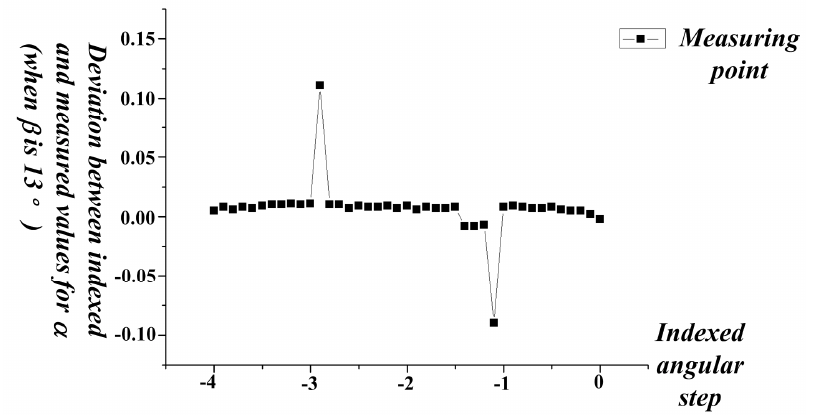
Figure 13. Deviation between indexed and measured values for α angle. Table 1. α changes with each 0.01°, the detection output value of ball joint.